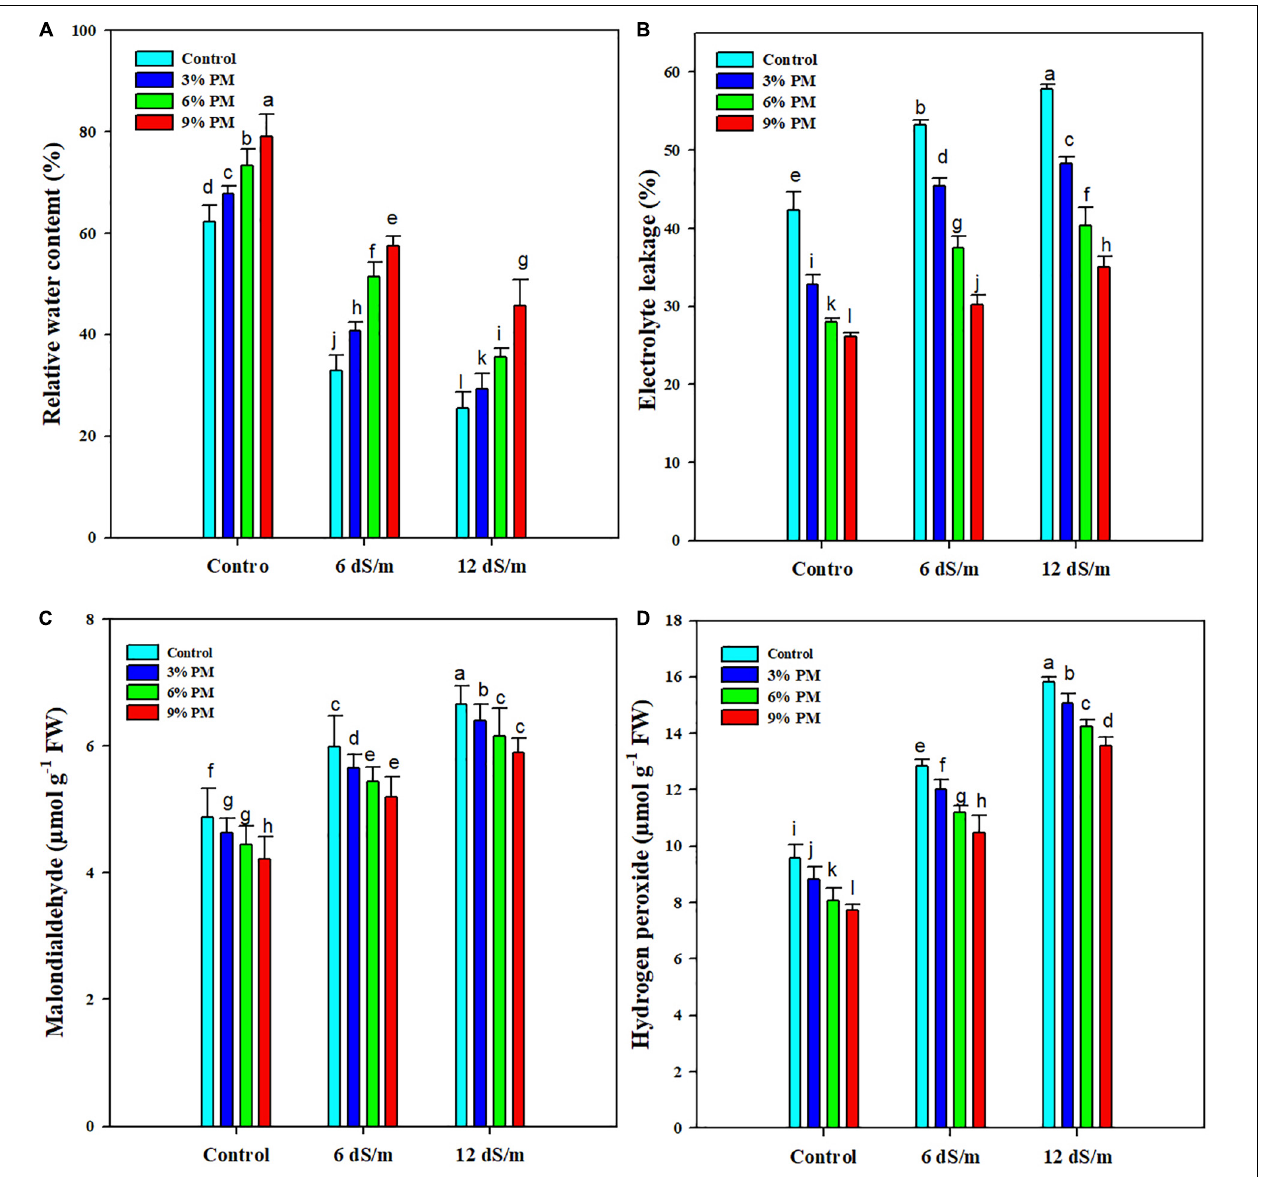
FIGURE 2 | Effect of different levels of press mud application on RWC (A) , EL (B) , MDA (C) , and H 2 O 2 (D) contents of rice crop grown under different levels of salinity stress. The bars indicate the means of three replications with ± S.E. and a different letter indicating significant differences at p <